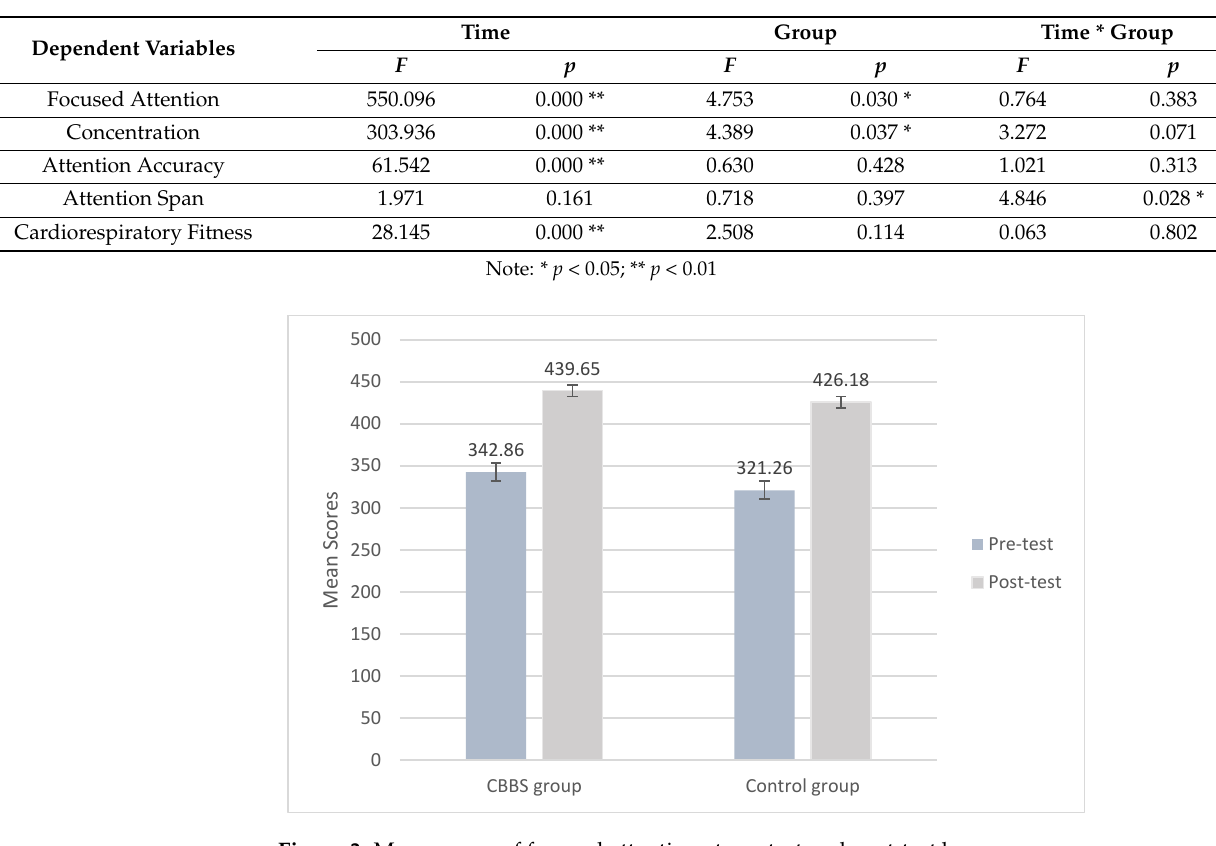
Figure 3 . Mean scores of focused attention at pre-test and post-test by group Figure 3. Mean scores of focused attention at pre-test and post-test by group.